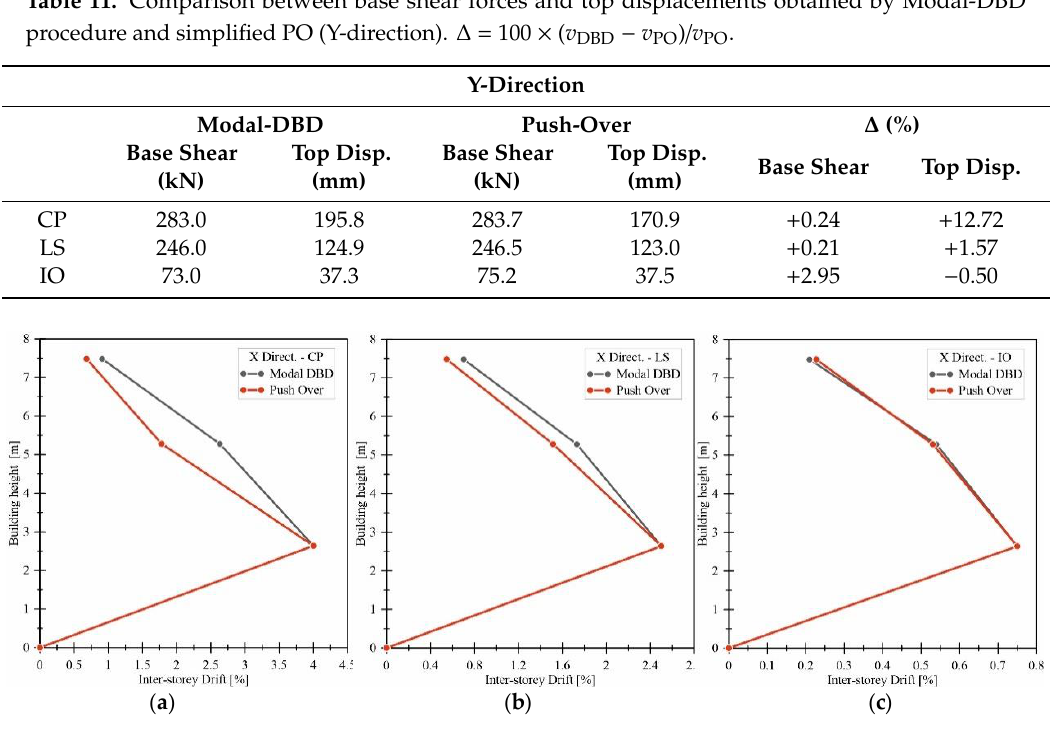
Table 10. Comparison between base shear forces and top displacements obtained by Modal-DBD